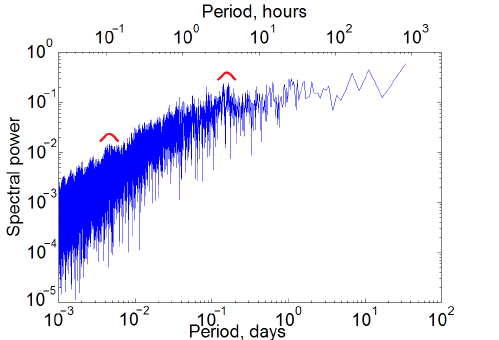
Figure 7. Fourier spectrum of variations in signal deviations from a daily mean at the NSB station for the period 22 January–24 February 2014. Maxima at the periods of 5–10 min and 3–4 h are shown by red